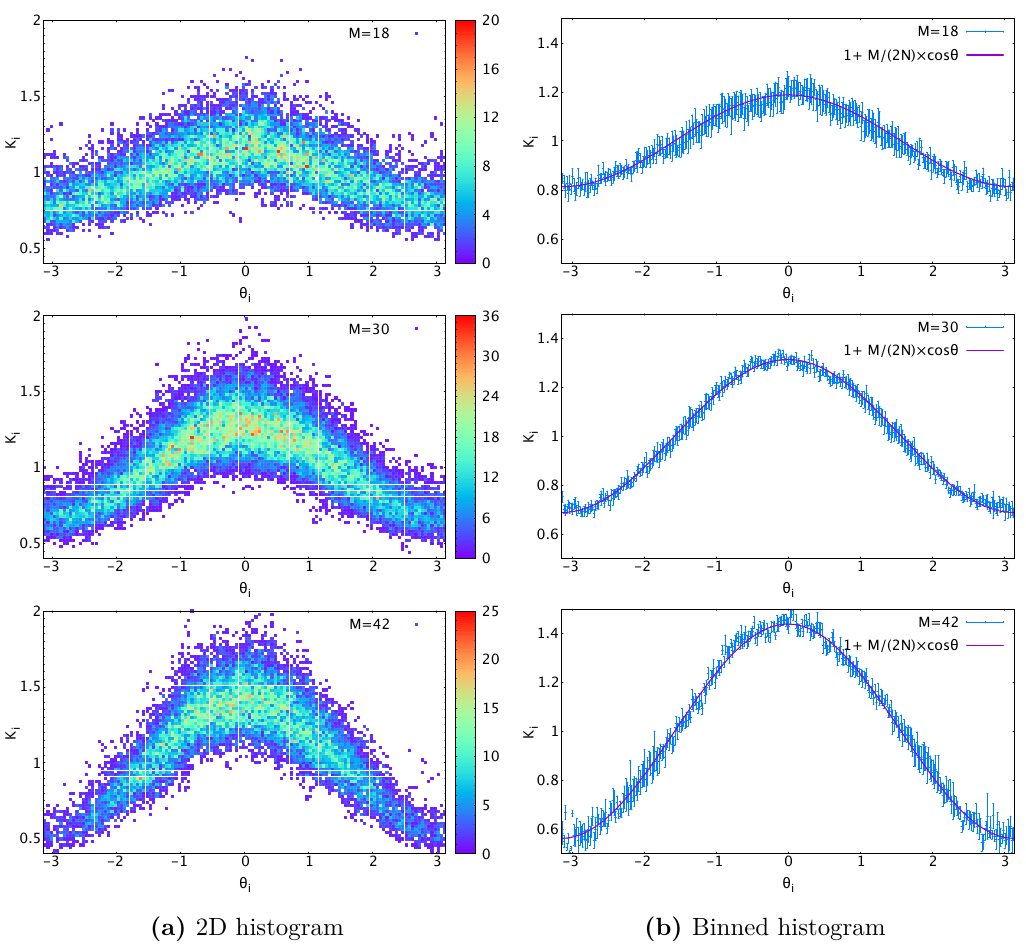
Figure 8. Gaussian matrix model, θ i vs K i , N = 48 , d = 2 , the number of lattice sites L = 16 , at T = T c = 1 . The center symmetry is fixed sample by sample such that P = | P | . (a) The log2 two-dimensional histograms of ( θ i , K i ). (b) The averaged K i within the narrow bin ∆ θ = 0 . 02 . The magenta lines are 1 + M cos θ . The error bars are obtained by jackknife analysis. 2 N holds with good accuracy when compared to binned histograms. These histograms are cre- ated by taking the average over the samples K falling into a θ bin of size ∆ θ = 0 . 02 . The i i fluctuation at each fixed θ can be understood as the finite- N effect which should be sup- i pressed as N becomes larger. By using the distribution of θ in the confined and deconfined i sectors ( 1 and 1+cos θ 2 π 2